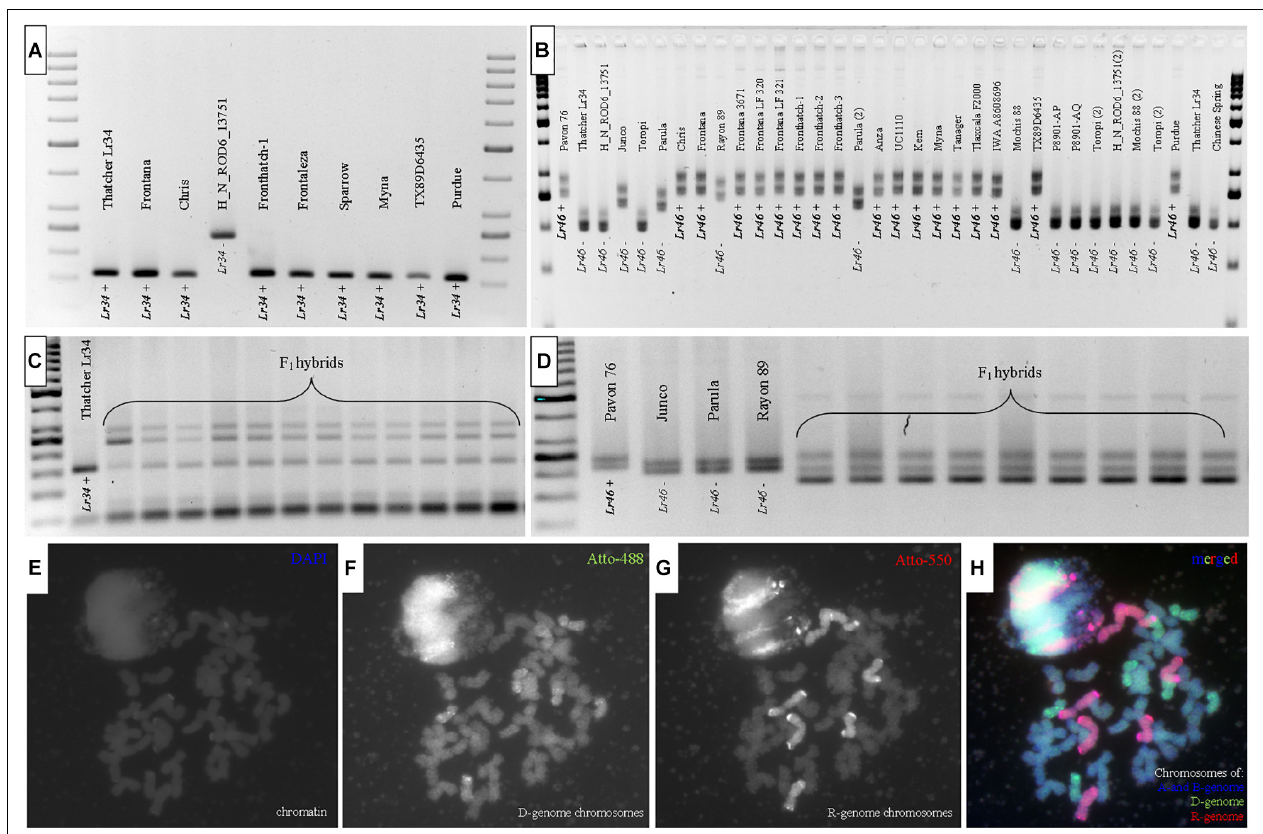
FIGURE 1 | Amplification products of PCR reactions of (A) wheat accessions (pollen donors) and (C) F 1 hybrids with csLV34 marker linked to Lr34 (= Yr18/Sr57/Pm38 ) locus and (B) wheat accessions and (D) F 1 hybrids with Xgwm44 marker linked to Lr46 (= Yr29/Sr58/Pm39 ). Lr34 or Lr46+ indicate resistant alleles; Lr34- or Lr46– indicate susceptible alleles. Genomic in situ hybridization preformed on mitotic chromosomes of plants derived through cross-hybridization between triticale and wheat: (E) chromatin (DAPI), (F) D-genome chromosmes (Atto-488, green), (G) R-genome chromosomes (Atto-550, red), (H)